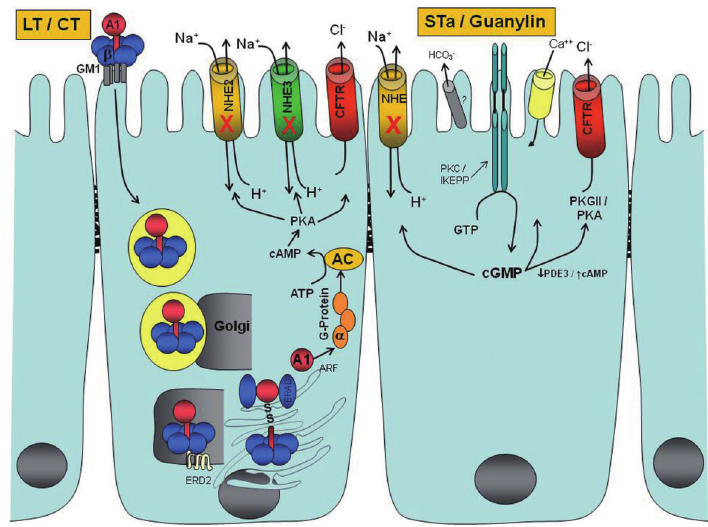
Figure 1. Mechanisms of action of the cholera toxin (CT), heat-labile (LT) and heat-stable enterotoxin (STa) from Escherichia coli , and endogenous peptide ligands of guanylyl cyclase C (GC-C). CT or LT binds to the monosialogan- glioside GM1 receptor at the host mucosa surface and triggers endocytosis of the holotoxin. The A1 domain of the A subunit is transported through the Golgi complex and endoplasmic reticulum to activate the Gs a subunit of G- protein. This A1 domain interacts with ADP- ribosylating factors to ADP-ribosylate this Gs a subunit in order to activate G-protein and consequently adenylyl cyclase (AC). The AC cleaves ATP to cAMP and subsequently acti- vates protein kinase A, which inhibits NaCl absorption (NHE transporters) and increases chloride secretion through the cystic fibrosis transmembrane regulator (CFTR). Peptide ligands of the extracellular domain of GC-C activate the intracellular catalytic domain of GC-C resulting in cGMP formation, which acti- vates several pathways: a) inhibition of the NHE3 transporter, which decreases NaCl absorption; b) activation of CFTR, which leads to secretion of chloride; and c) increased calcium